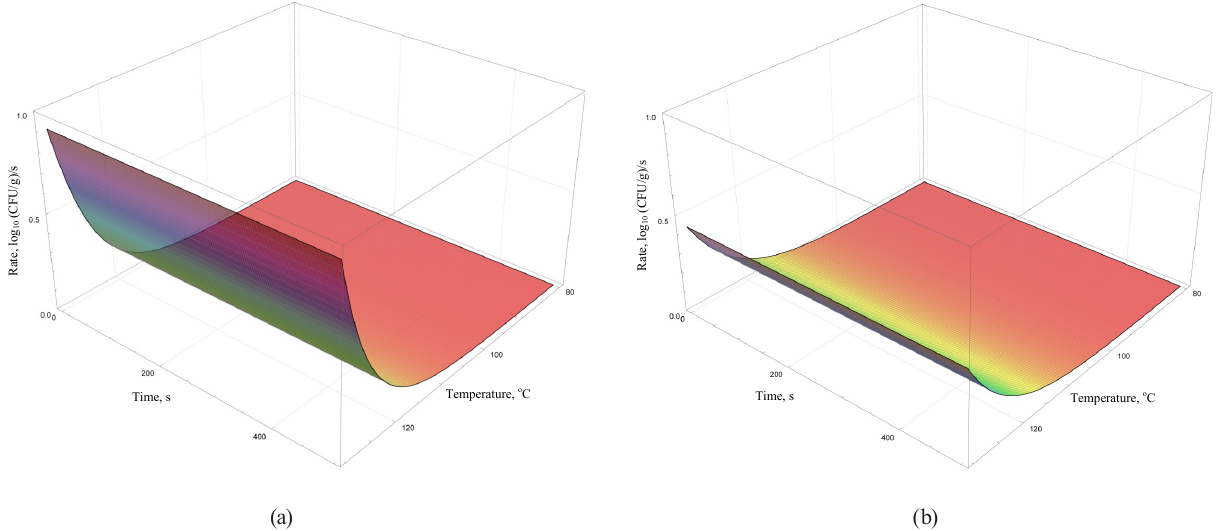
(a) (b) Figure 10 Model of the rate dynamics for microbial death kinetics of A. acidoterrestris during heat treatment. (a) Whiting-Buchanan model, (b) Weibull model.